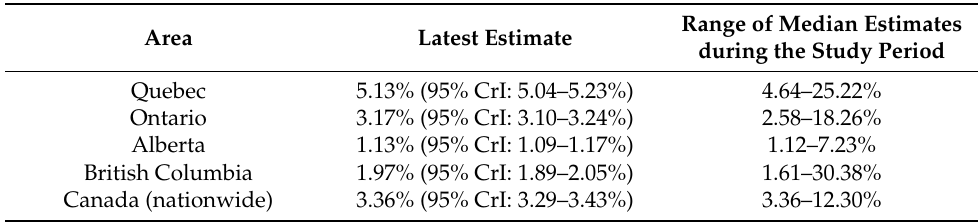
Figure 3. Crude case fatality rate (CFR; red line) and adjusted CFR estimates (black line) in ( a ) Quebec, ( b ) Ontario, ( c ) Alberta, and ( d ) British Columbia, up to 15 December 2020. The shaded area around the black line illustrates the 95% CrI for the adjusted CFR. Table 3. Time-delay adjusted case fatality rate (CFR) of COVID-19 in four provinces of Canada (Quebec, Ontario, Alberta, and British Columbia) and nationwide (as of 15 December 2020).